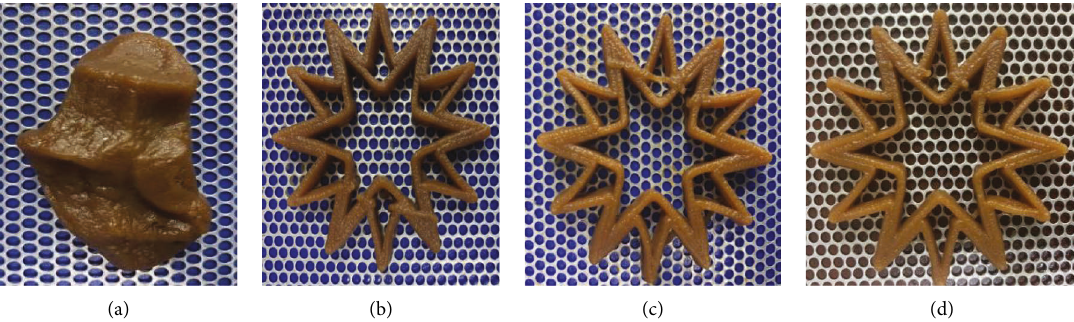
Figure 2: Sample images of (a) Control (b) S